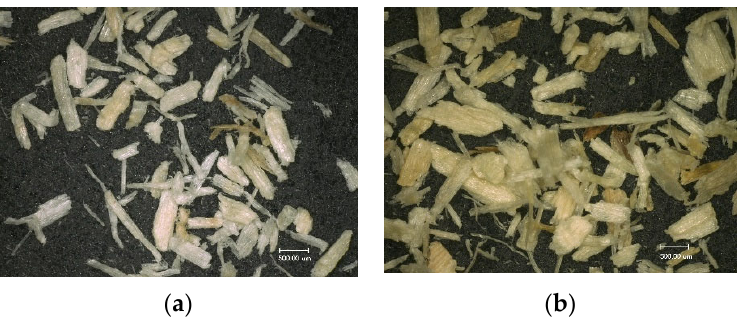
Figure 1. ( a ) Microscope image of Arbocel C320. ( b ) Microscope image of Lignocel BK40/90.